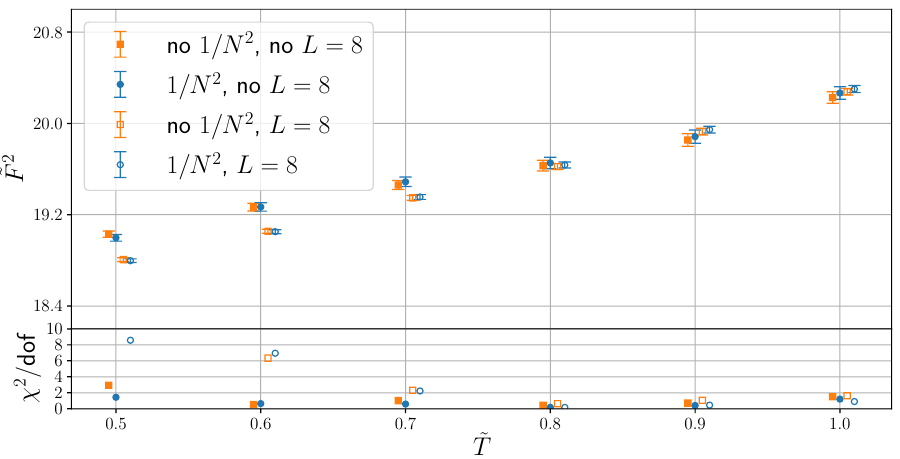
Figure 15. The values of ~ F 2 in the gauged theory (and the reduced (cid:31) 2 ) as a function of the temperature from di(cid:11)erent simultaneous large- N and continuum extrapolations: with and without 1 =N 2 corrections and with and without L = 8 data points. The error bars of the individual points at (cid:12)xed N , L and ~ T used in the extrapolations have been increased by a factor of two.